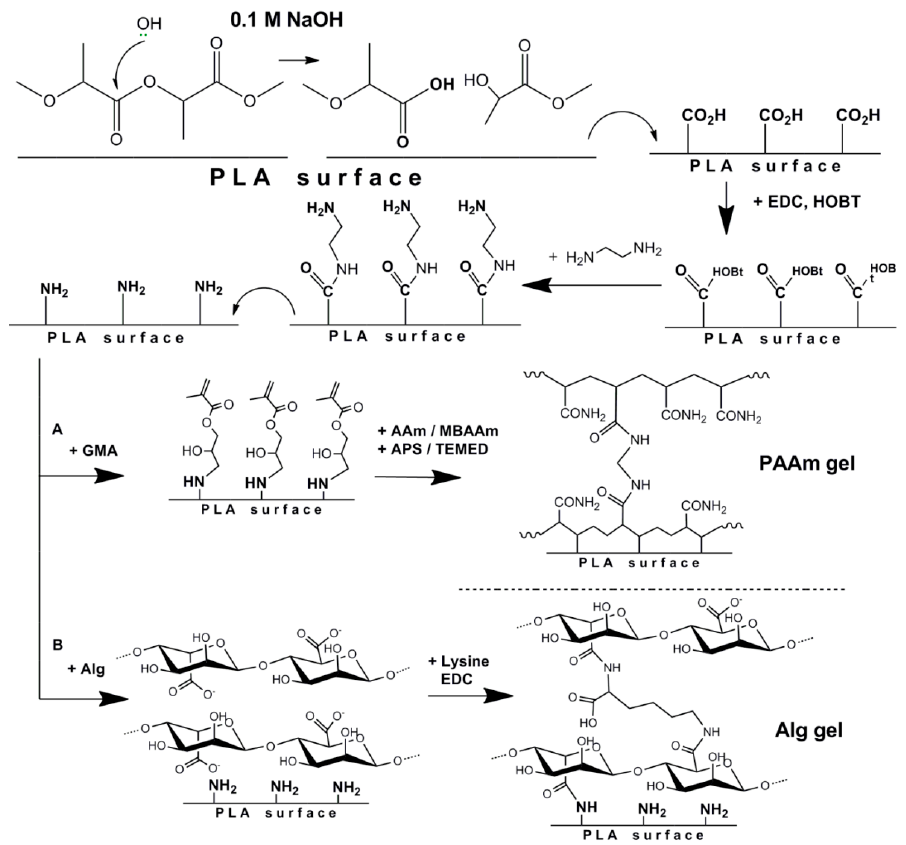
Figure 2. Scheme of the modification of PLA and formation of hydrogel films using two approaches: ( A ) copolymerization of acrylamide with methylene-bis-acrylamide; ( B ) cross-linking of alginate with lysine.